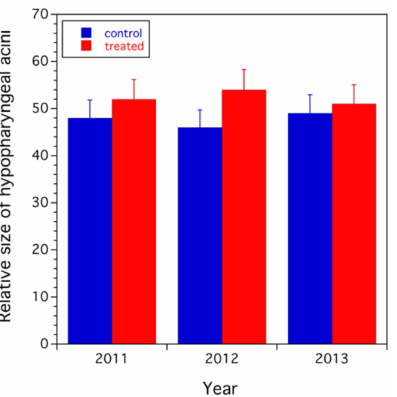
Figure 9. Relative size (surface area) of hypopharyngeal acini over three years. Error bars are standard